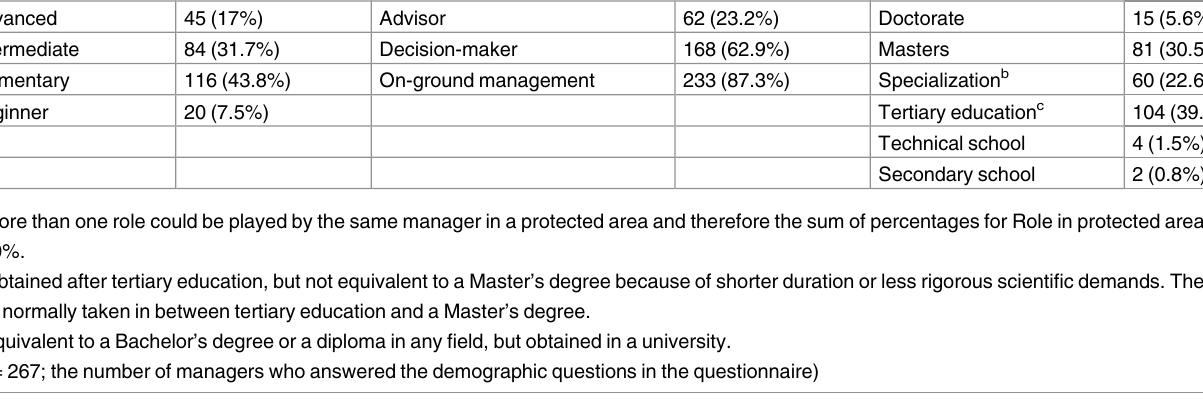
Table 3. Description of the sample of managerswho responded to the questionnaire regarding their standard of English fluency, role in protected area, and education level. English